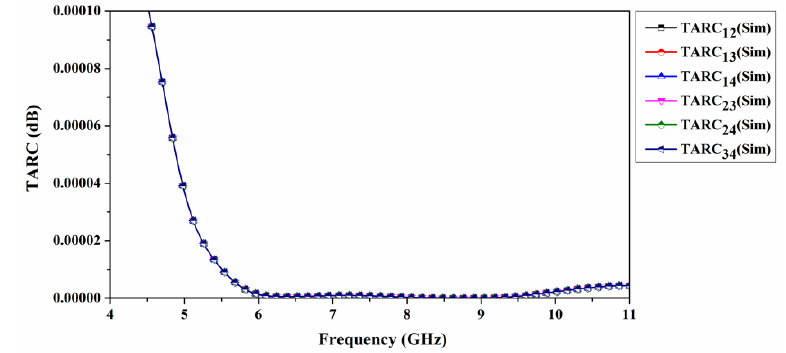
Figure 12. Simulated total active reflection coefficient of quad-port antenna.